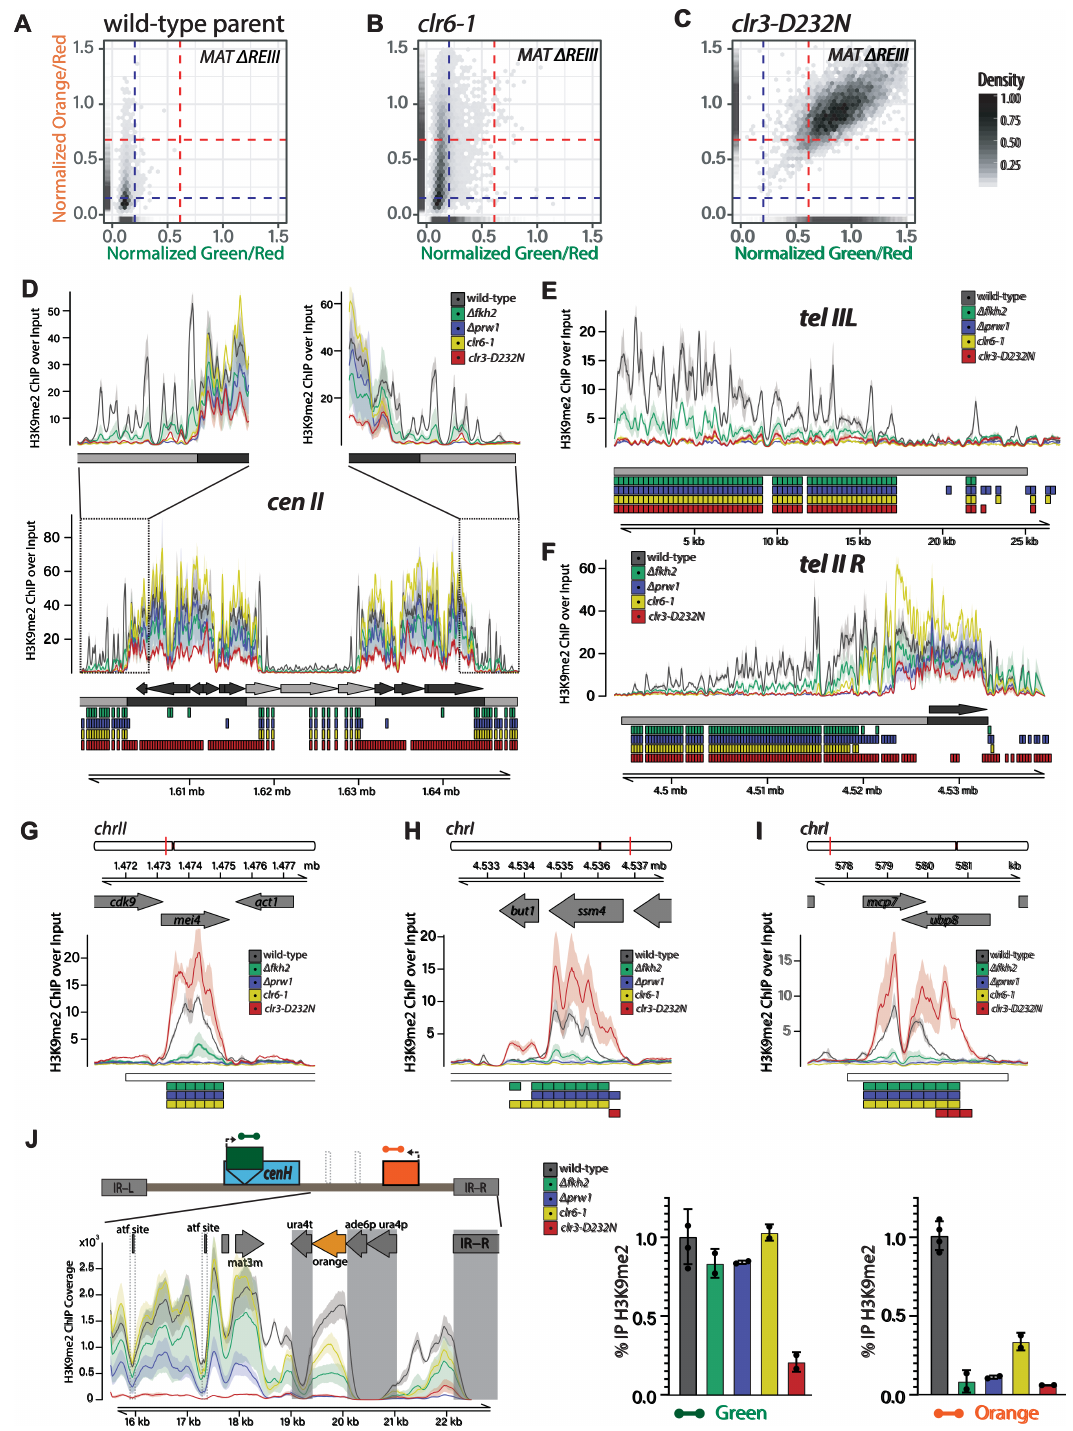
Fig 5. Fkh2- containing Clr6 Complexes regulate H3K9me2 spreading at constitutive and facultative heterochromatin loci. A.-C. The hypomorphic clr6-1 allele exhibits a loss of nucleation-distal silencing, while the catalytic dead clr3-D232N allele loses all silencing. 2D density hexbin and rug plots in the MAT Δ REIII background of the parent strain ( A. ) run together with B. & C.; clr6-1 ( B. ); and clr3-D232N ( C. ). A rug plot is included on the X and Y axes indicating the 1D density for each color. Rug lines are colored with partial transparency to assist with visualization of density changes. Dashed blue lines indicate the values for repressed fluorescence state